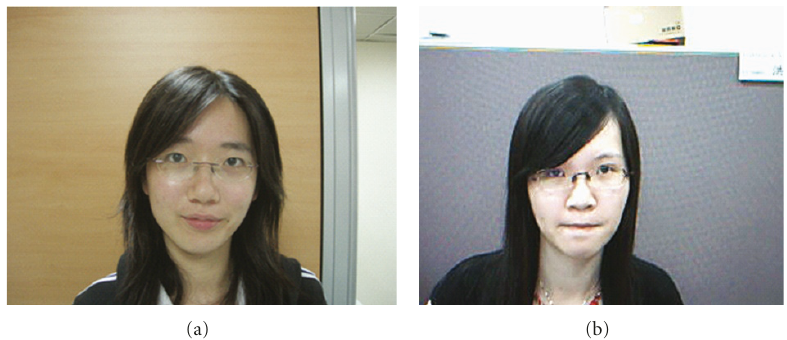
Figure 25: The example of false acceptance for (a) an impostor and (b) a